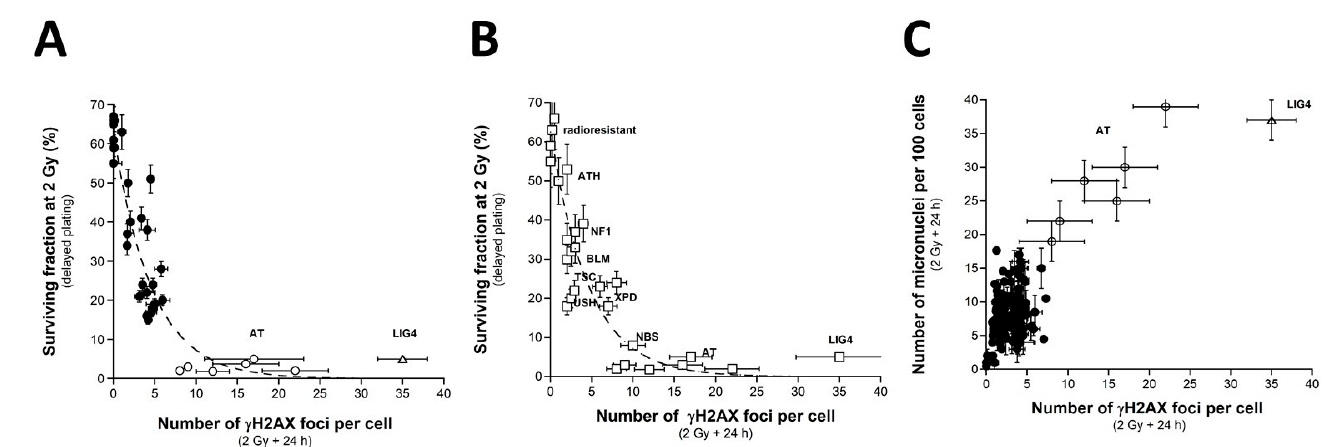
Figure 5. SF2 vs. γ H2AX foci and micronuclei vs. γ H2AX foci ( A ) The SF2 data from 36 COPERNIC cell lines were plotted against the corresponding number of γ H2AX foci per cell assessed 24 h post-irradiation (closed circles). Each point corresponds to the mean ± standard error of the mean (SEM) of three independent triplicates, at least. The best data fit was obtained with the linear law: SF2 (%) = 62.56 exp ( − 0.216 H2AX 24h ); r 2 = 0.87 (dotted line). ( B ) The SF2 values ( ± SEM) and the γ H2AX foci assessed 24 h post-irradiation ( ± SEM) from fibroblasts deriving from patients suffering from the indicated syndromes (open squares) (AT: ataxia telangiectasia, homozygous mutations of ATM ; LIG4: homozygous mutations of LIG4 ; NBS: Nijmegen’s syndrome, homozygous mutations of NBS1 ; XPD, xeroderma pigmentosum D, homozygous mutations of XPD ; USH, Usher’s syndrome, homozygous mutations of USH; TSC, tuberous sclerosis, heterozygous mutation of TSC ; Bloom’s syndrome, homozygous mutations of BLM ; NF1, neurofibromatosis type 1, heterozygous mutations of neurofibromin; ATH, heterozygous mutations of ATM ). The dotted line is the reproduction of the data fit shown in ( A ). The syndromes data were obtained from our lab and published else- where [3,15,30,43]. ( C ) The number of micronuclei assessed 24 h post-irradiation shown in Figure 2A (from 200 COPERNIC cell lines) was plotted against the corresponding numbers of γ H2AX foci per cell assessed 24 h post-irradiation shown in Figure 4. The points corresponding to the ATM - (open circles) and the LIG4 - (open triangles) mutated cell lines are